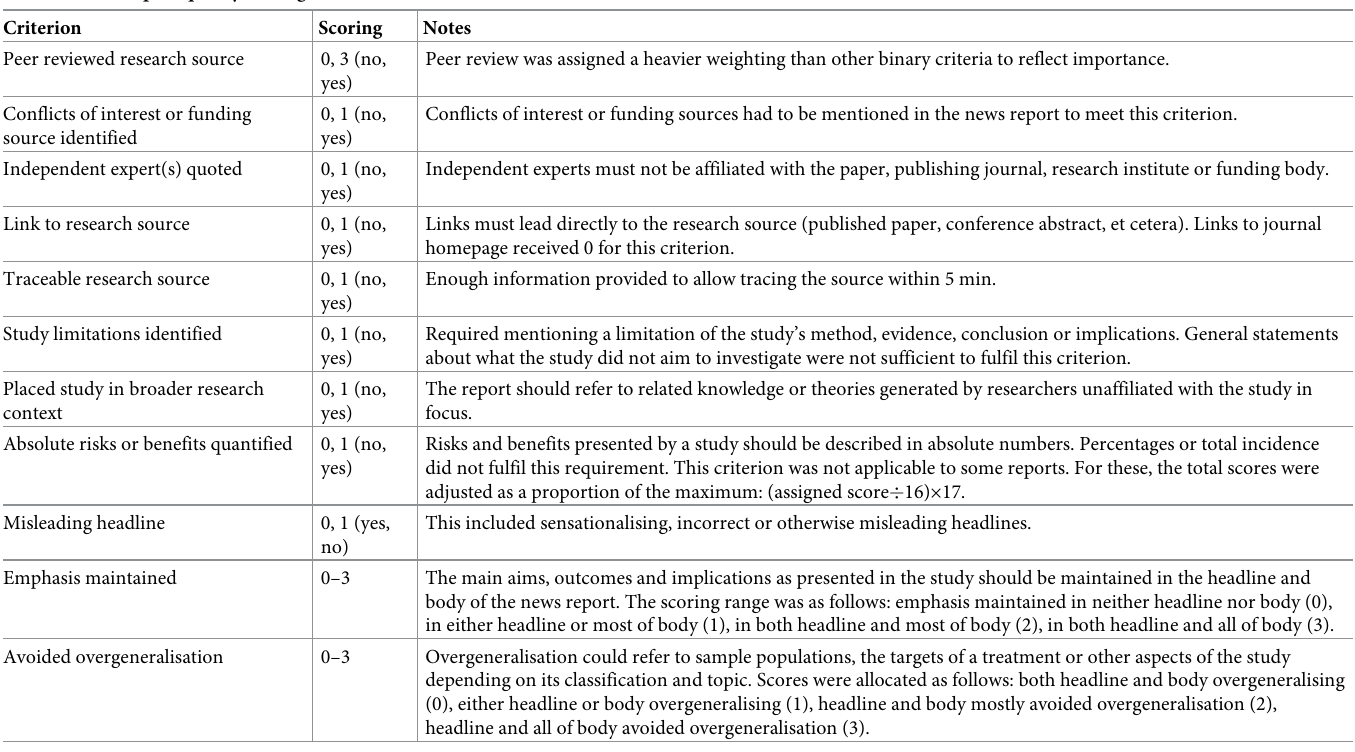
Table 1. News report quality scoring